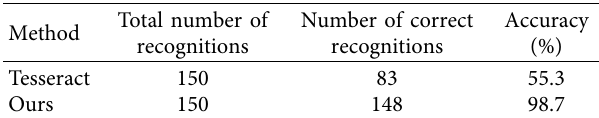
Table 2: Recognition results.